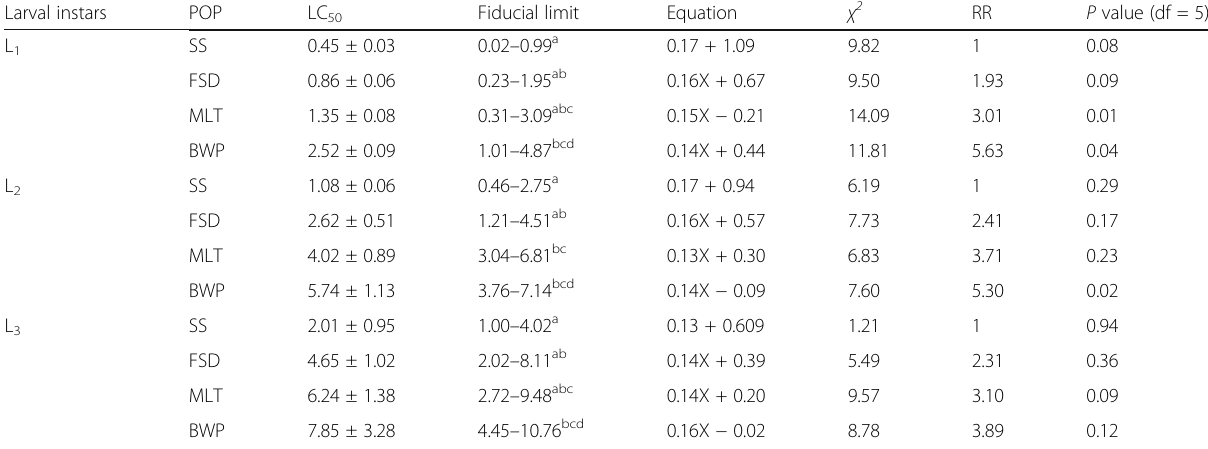
Table 1 Lethal concentration of susceptible and field population of Spodoptera exigua to Cry1Ac toxin during 2015 Larval instars POP LC 50